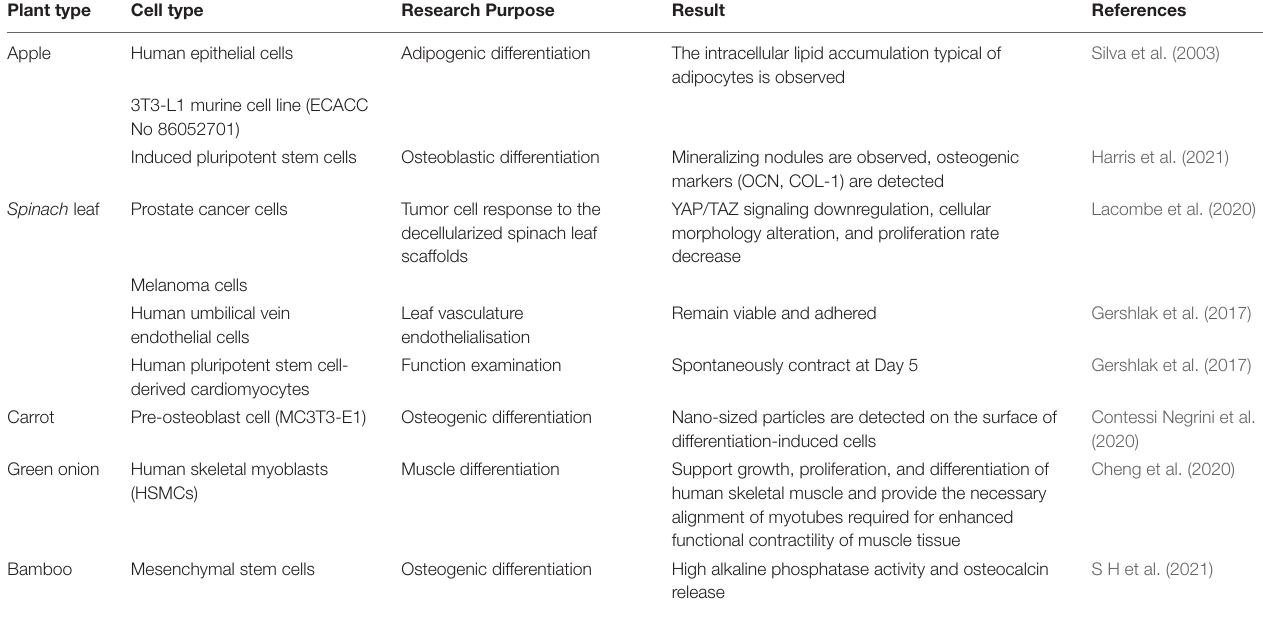
TABLE 4 | Review of plant scaffold recellularization